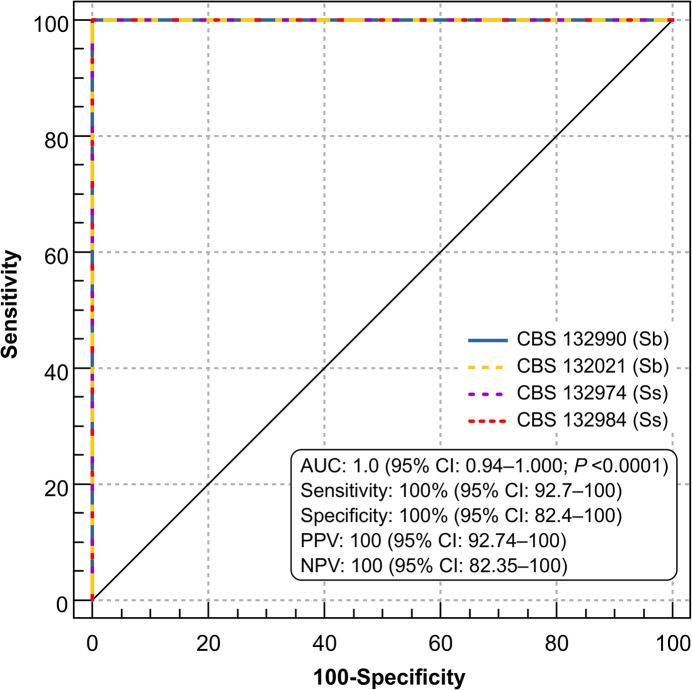
ROC analysis of assay sensitivity and specificity.Samples consisted of sera from 49 infected cats and 19 uninfected cats. Sb, S. brasiliensis; Ss, S. schenckii; PPV, positive predictive value; NPV, negative predictive value.